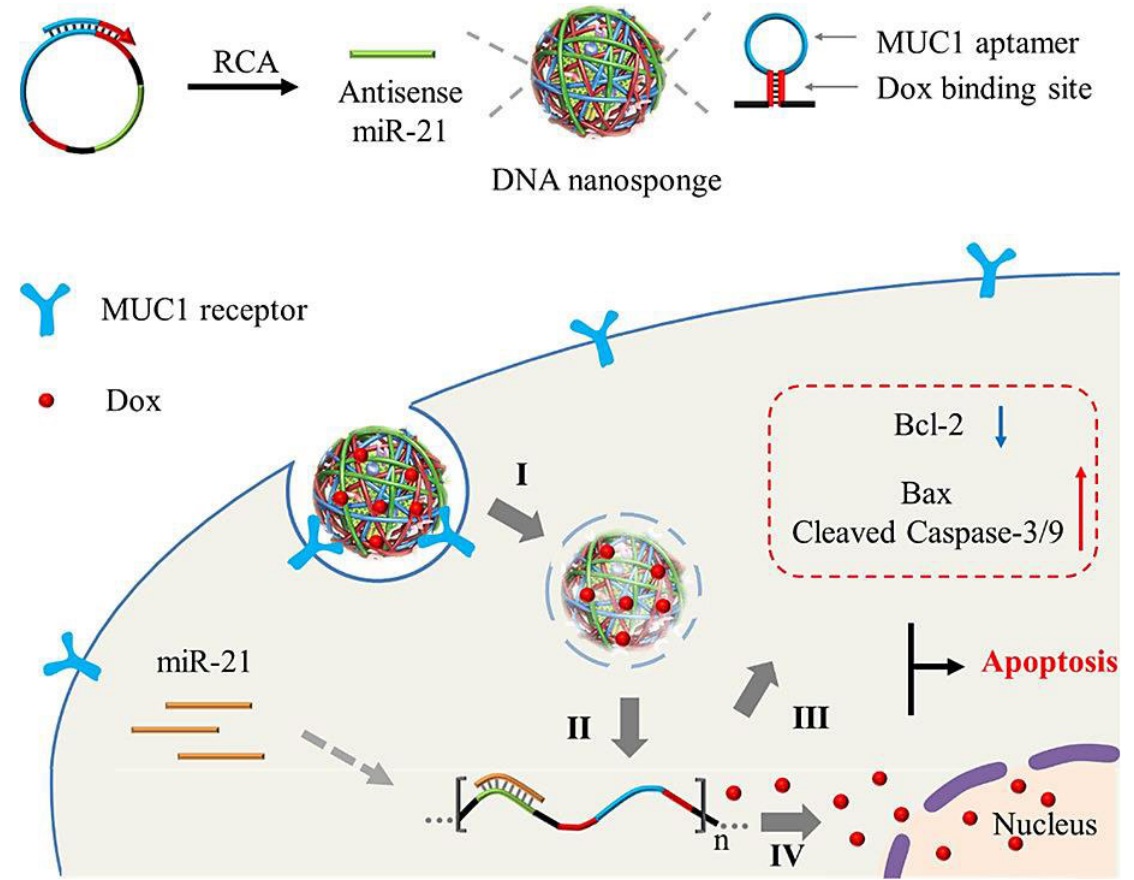
Figure 5. DNA nanosponges created for the clearance and adsorption of intracellular miRNA-21 (miR-21), along with regulatory effects of gene expression in tumor cells for synergistic and specific antitumor chemotherapy (I-IV) . RCA: rolling circle amplification; Dox: doxorubicin. Adapted from [72] with permission. Copyright 2019 American Chemical Society.